Question: What direction does the quantity move in — increasing or decreasing?
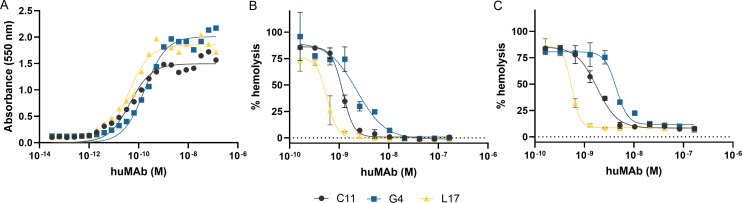
Answer: increasing